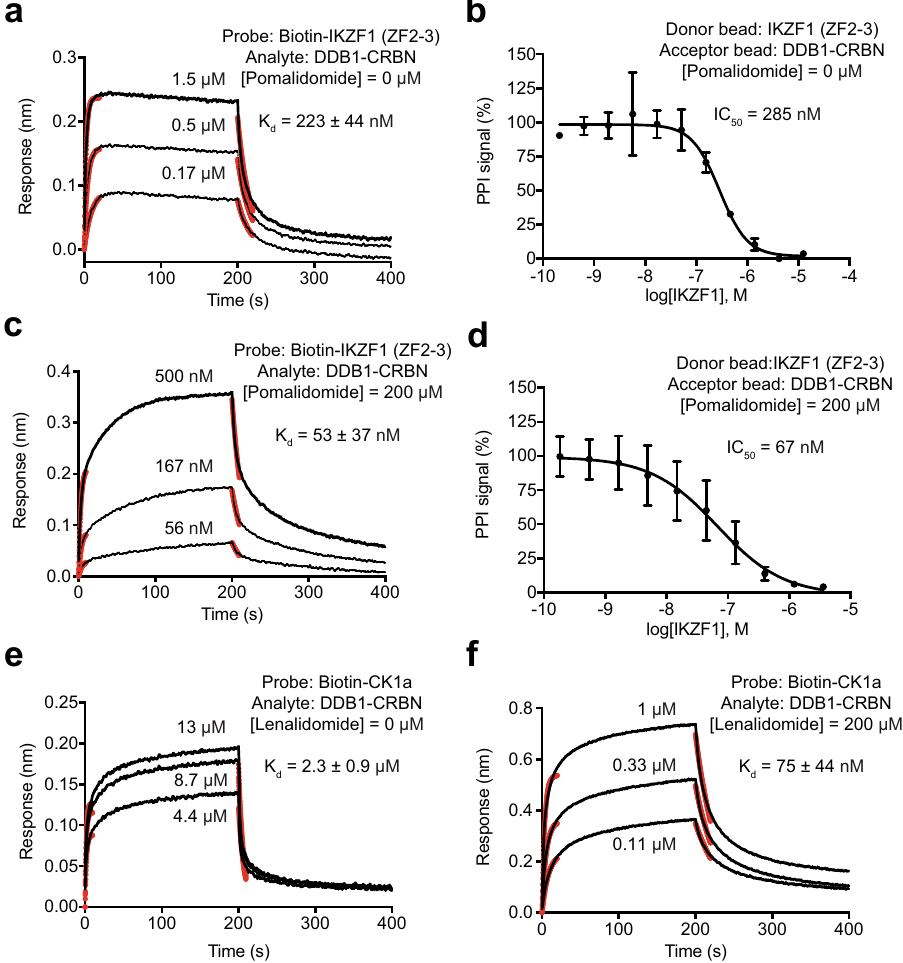
Fig. 6 Quantitative analysis of IMiDs system. a , b BLI and AlphaScreen competition assays for assessing the intrinsic af fi nity of IKZF1 (ZF2-3) to DDB1 – CRBN. Red lines represent curve fi tting at the initial phase of association and dissociation. K d , dissociation constant. IC 50 , half-maximum inhibitory concentration. Data were presented as mean ± s.d. of n = 3 biologically independent samples. Source data are provided as a Source Data fi le. c , d BLI and AlphaScreen competition assays for assessing the af fi nity of IKZF1 (ZF2-3) to DDB1 – CRBN in the presence of pomalidomide at a saturating concentration. Red lines represent curve fi tting at the initial phase of association and dissociation. K d , dissociation constant. IC 50 , half-maximum inhibitory concentration. Data were presented as mean ± s.d. of n = 3 biologically independent samples. Source data are provided as a Source Data fi le. e , f BLI measurements of CK1a and DDB1 – CRBN interaction in the absence and presence of lenalidomide at a saturating concentration. Red lines represent curve fi tting at the initial phase of association and dissociation. K d , dissociation constant. Source data are provided as a Source Data fi